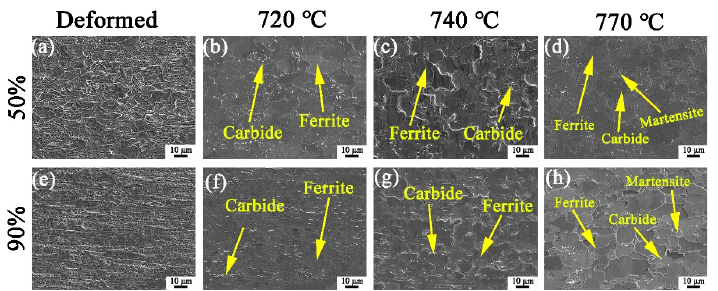
Figure 1. Microstructures of X2CrNi12 steel at 50% deformation ( a – d ) and 90% deformation ( e – h ) with different annealing temperatures, ( a , e ) deformed; ( b , f ) 720 °C; ( c , g ) 740 °C; ( d , h ) 770 °C.